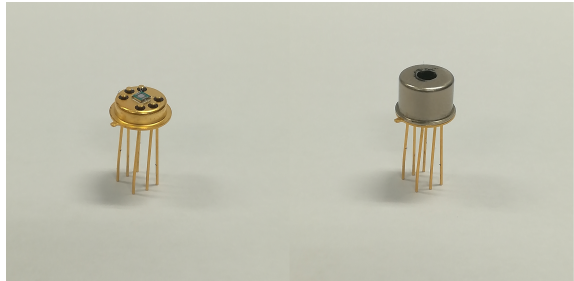
Figure 2. Photograph of the packaged sensor, both without and with the